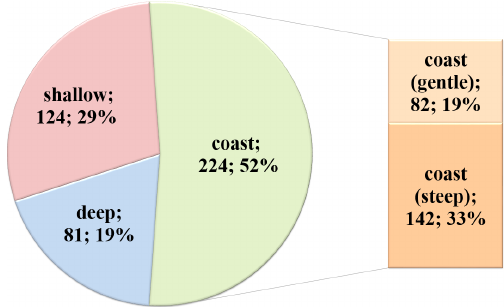
Figure 5. Distribution of deep, shallow, and coastal freak wave events.